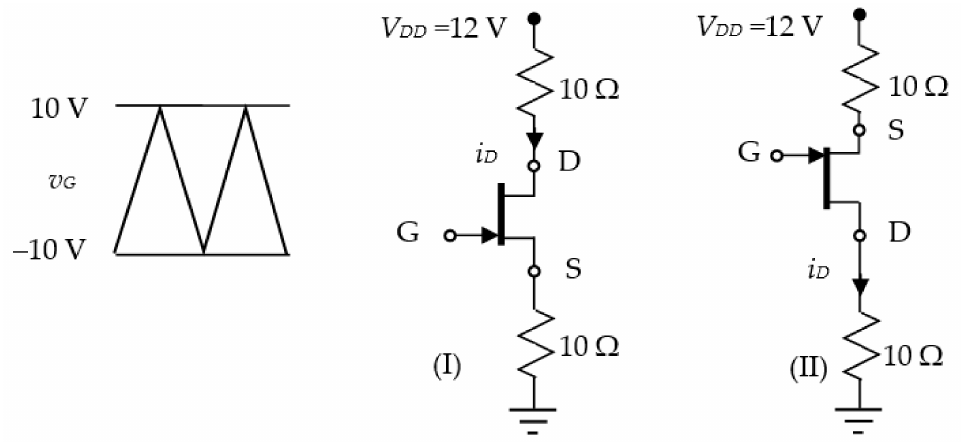
Figure 3. The triangular wave on–off experiment setups.